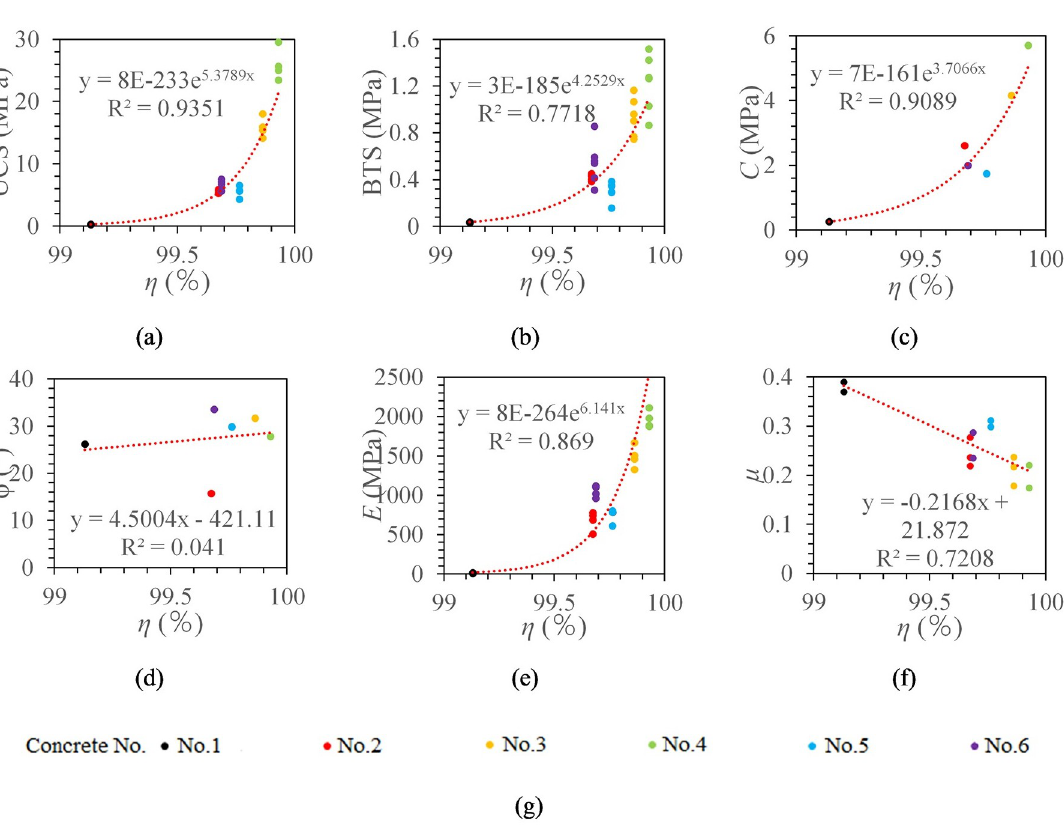
Fig 12. The relationship between torque work ratio and concrete mechanical properties. (a) The relationship between η and UCS. (b) The relationship between η and BTS. (c) The relationship between η and C . (d) The relationship between η and φ . (e) The relationship between η and E . (f) The relationship between η and μ . (g)